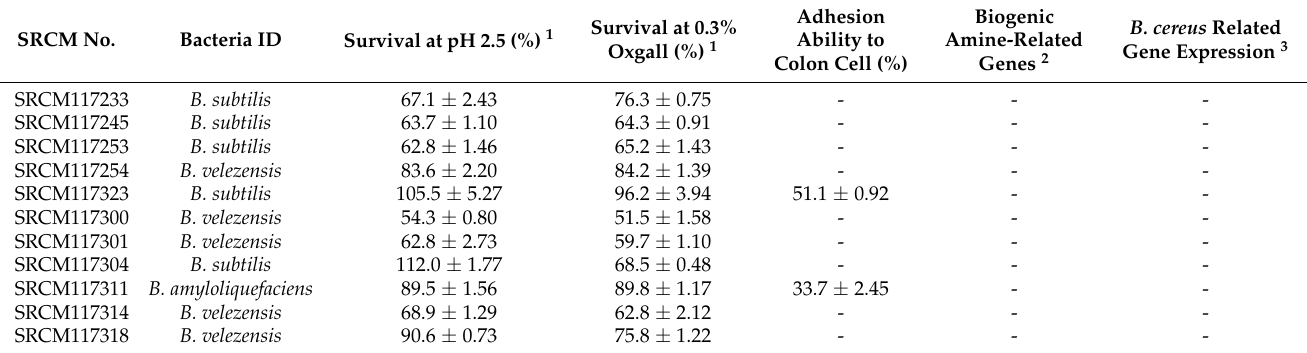
Values represented as means ± SD ( n = 3). 1 The percentage of the number of live cells after the reaction and before the reaction. 2 Determined by histidine decarboxylase (hdc) and tyrosine decarboxylase (tdc) expression. 3 CytK, nheA, ent FM, bceT, hblC, CER